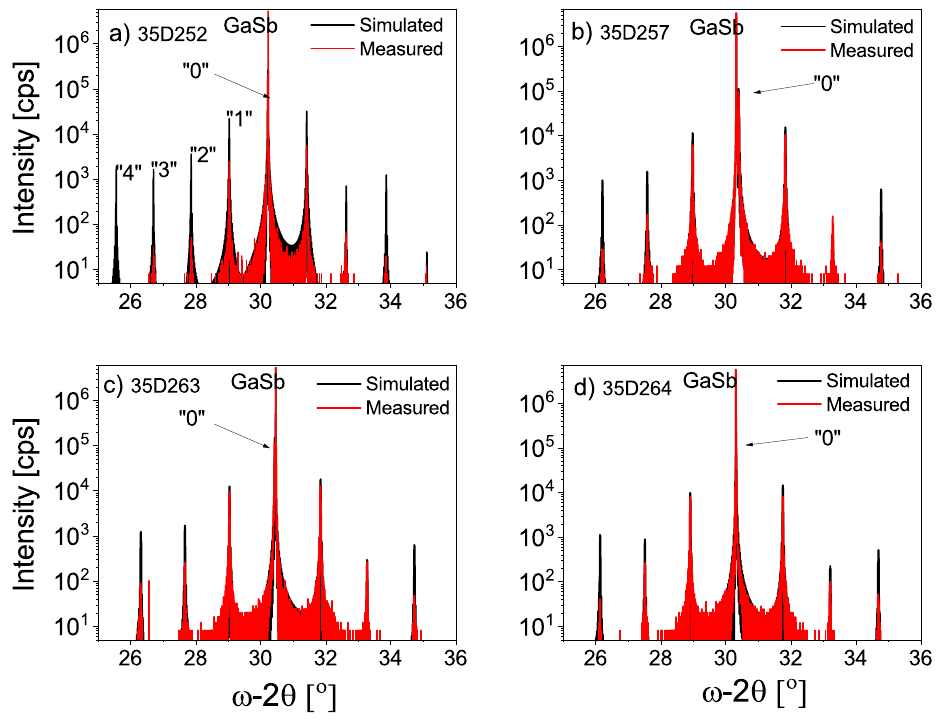
Figure 2. The X-ray 004 2 Θ - ω scan of four investigated InAs/AlSb T2SL on GaSb substrate: ( a ) 35D252, ( b ) 35D257, ( c ) 35D263, ( d ) 35D264.